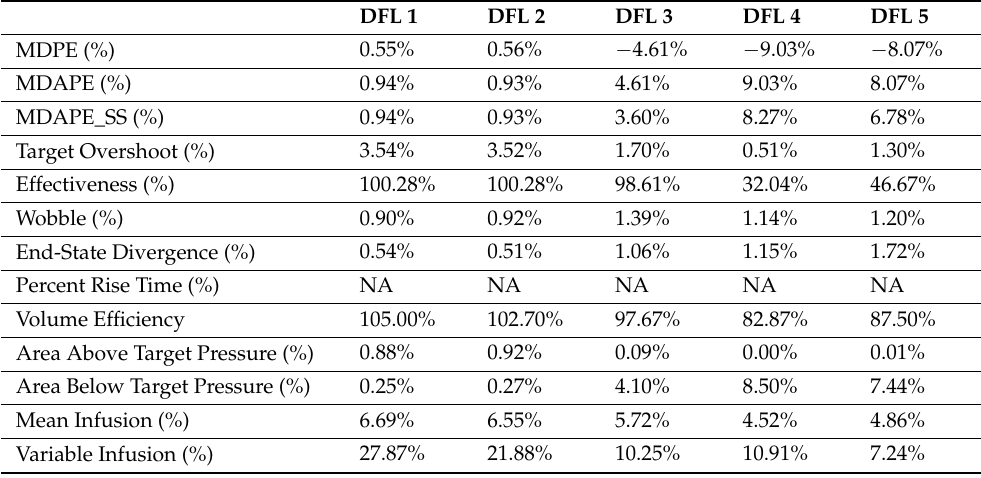
Table A2. Summary of performance metrics for Scenario 2. Performance metrics for each of five DFL controllers is shown as mean values for three subject variability